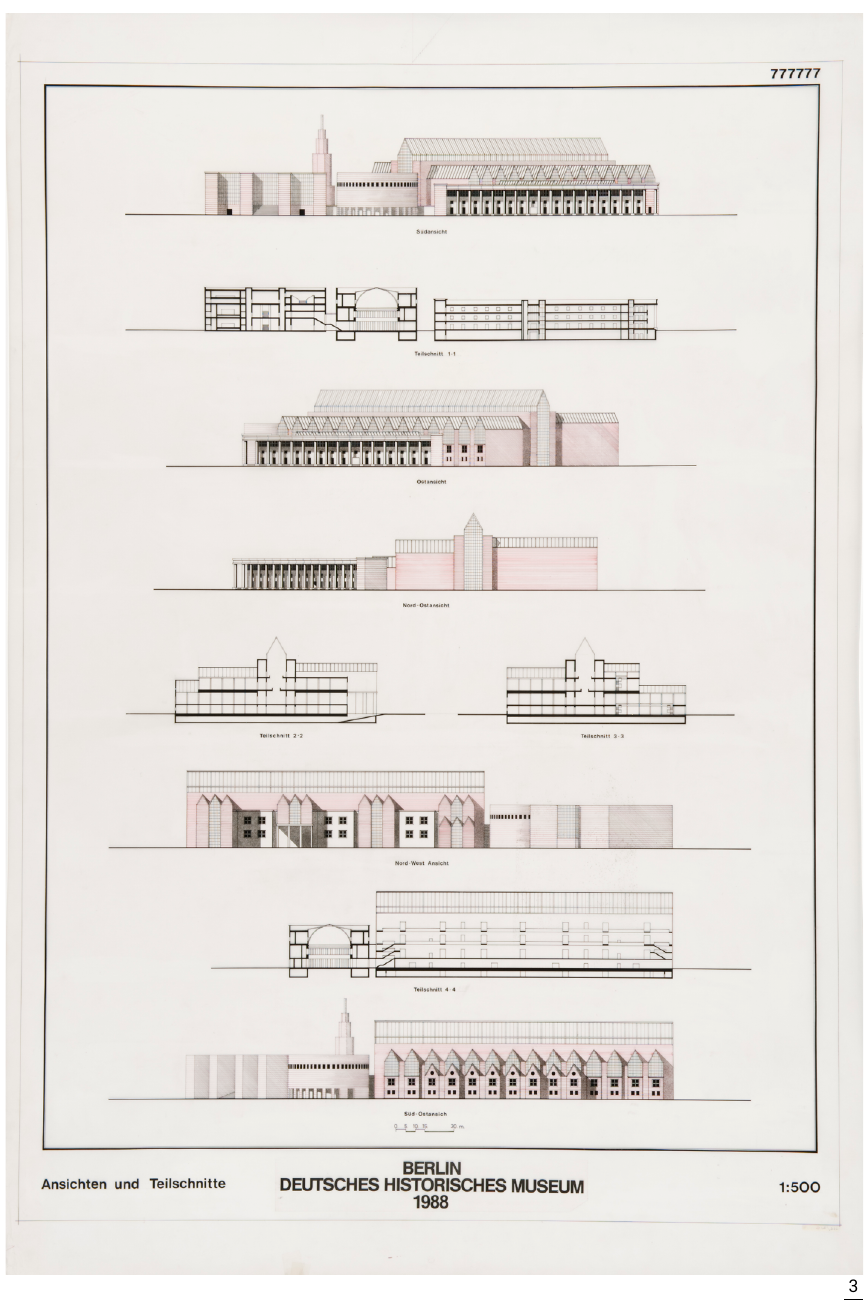
Fig. 3 Panel of the Rossi Studio competition entry, showcasing the project’s facades. Note the monumental south façade on top, the industrial-looking north-east and the vernacular house-shapes of the south-east one. (© Eredi Aldo